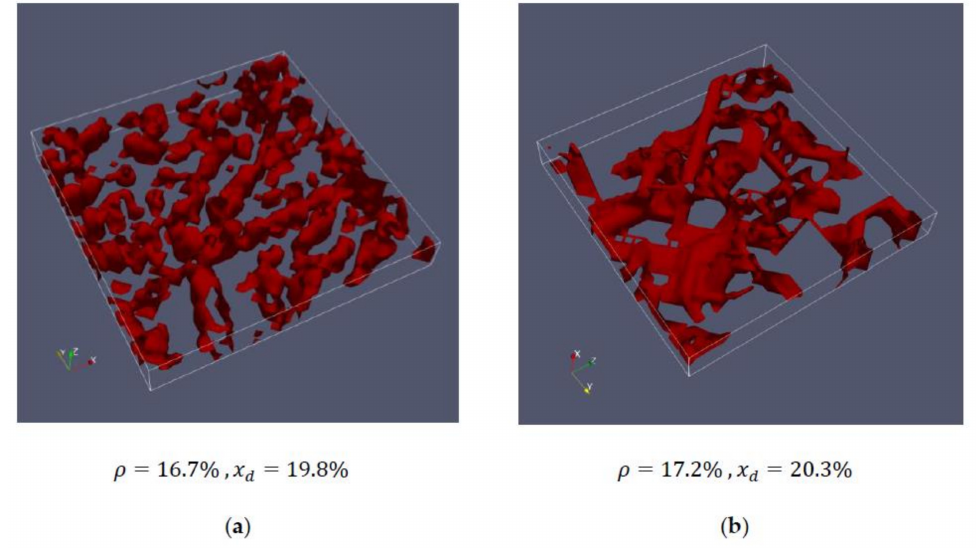
Figure 5. Comparison of a 10-layer actin network: ( a ) measured network of cell #4 ( b ) artificially generated network